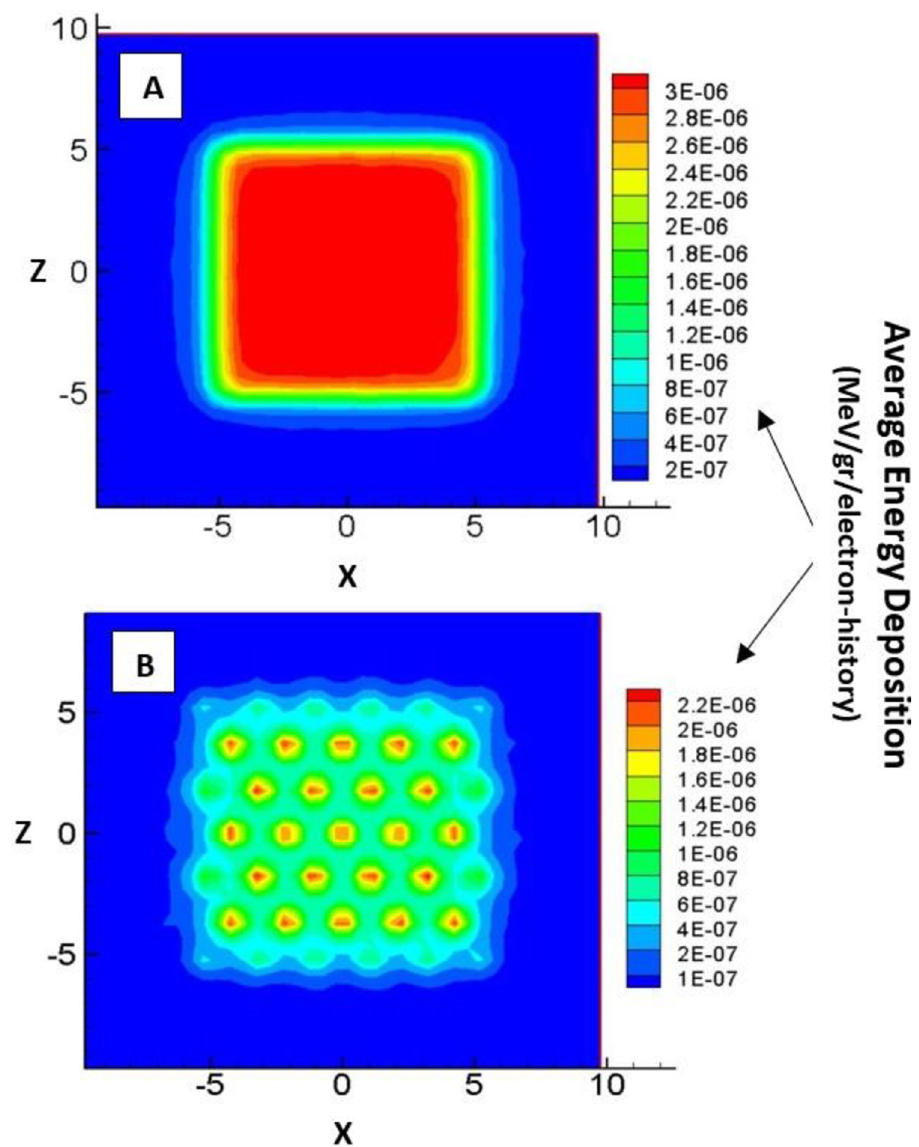
Fig 4. Two-dimensional dose profile at a depth of 5 cm inside the water phantom for the open field (A) and the field blocked by a brass grid (B).